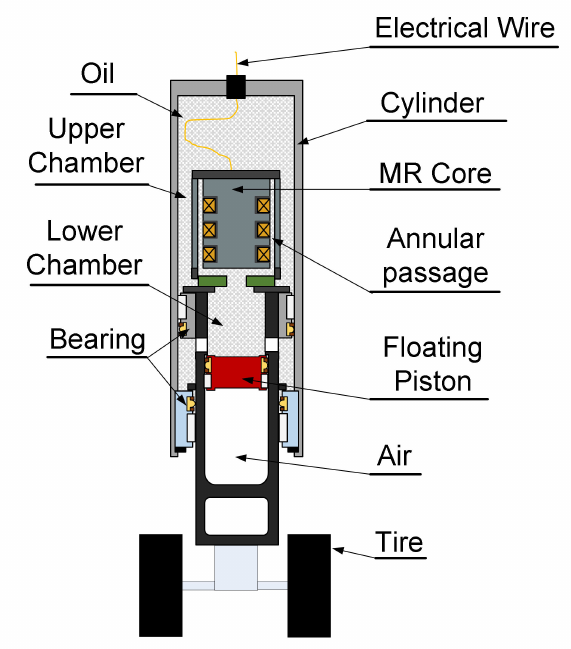
Figure 3. Structure of landing gear equipped with MR damper.